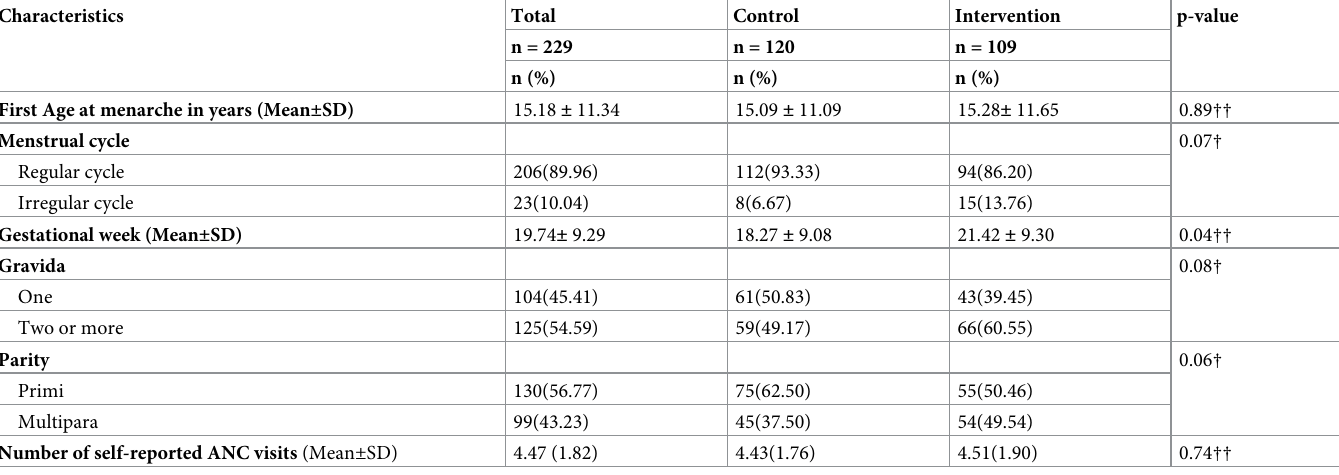
Table 4. Obstetric characteristics of the study participants in intervention and control group at baseline, n = 229. Characteristics